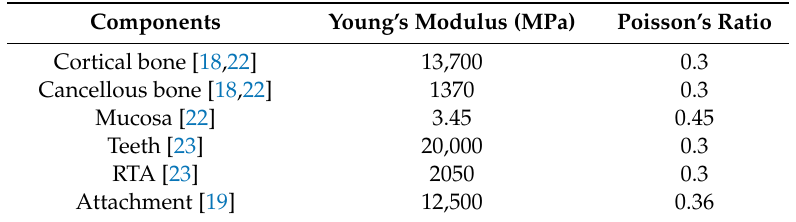
Table 1. Material properties of the components in the finite element models.